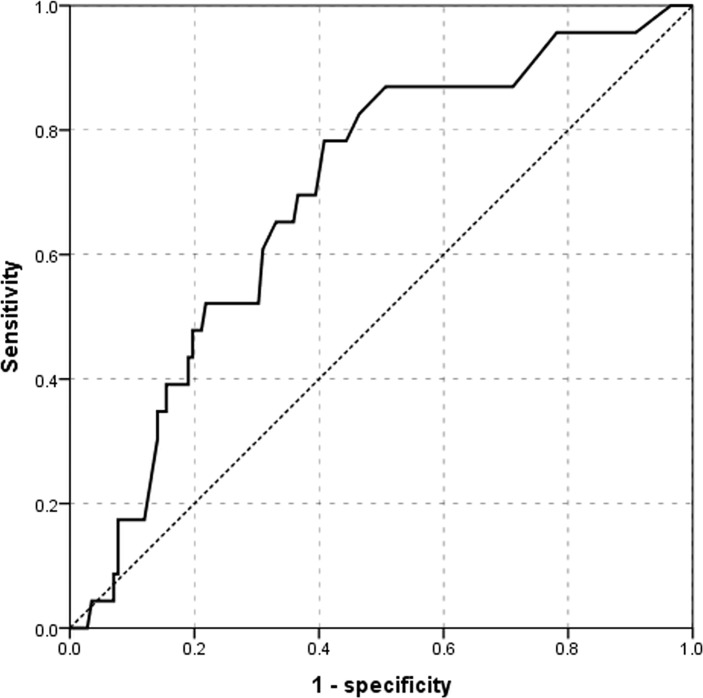
Receiver operating characteristic (ROC) curves of canal paresis (CP) on the lesion side according to magnetic resonance imaging (MRI).The ROC curves of the CP were plotted according to the patient group, as discriminated by MRI (idiopathic vs. secondary). The area under the curve for CP was 0.695, and the cut-off value was 34.5% (sensitivity 65.2%, specificity 67%).